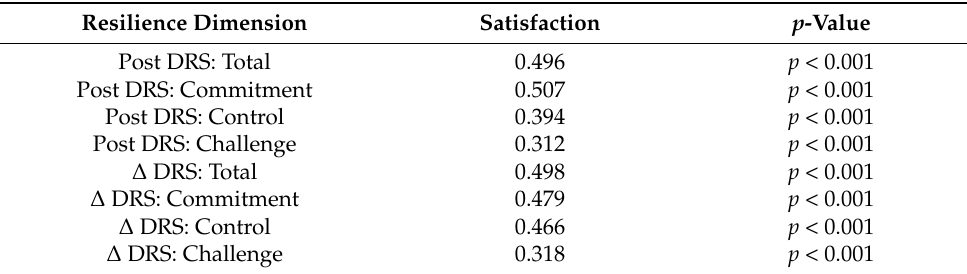
Table 13. Statistical correlation between satisfaction levels about ward/department reallocation due to COVID-19 and DRS scale with 4 scores (post and delta description).